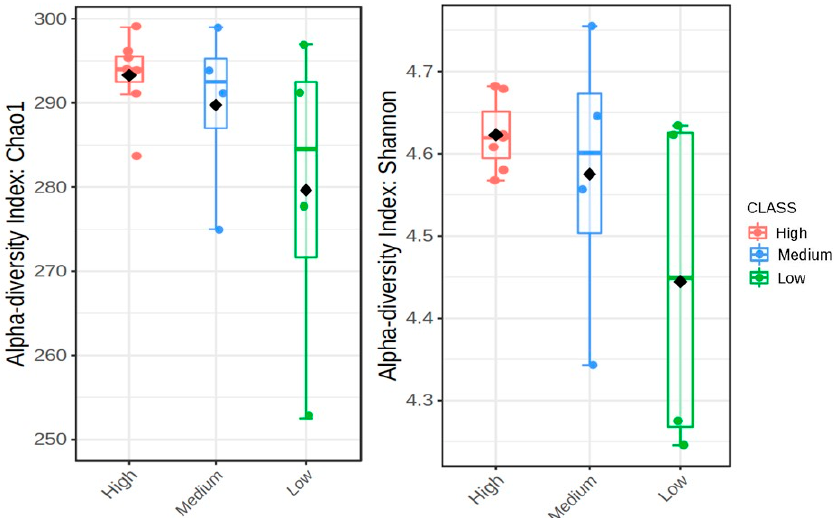
Figure 3. The alpha diversities with regards to Meloidogyne infection in soybean roots from the Highveld production area (Mpumalanga province) in South Africa presented as boxplots. The data was plotted with the Chao1 ( p = 0.211) and Shannon ( p = 0.170) diversity indices with p < 0.05; the median as well as highest and lowest values are indicated on each boxplot.